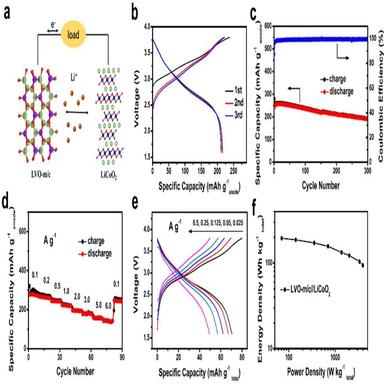
(a) Schematic illustration of the full cell. (b) Charge/discharge curves and (c) Cycling performance of LVO-m/c//LiCoO2 at 0.5 A g−1 . (d) Rate performance of LVO-m/c//LiCoO2 full cell. The specific capacity is based on the mass of anode. (e) Charge/discharge curves of LVO-m/c//LiCoO2 full cell at different current densities. (f) Ragone plots of LVO-m/c//LiCoO2. The specific capacity is calculated on the mass of total electrodes, including the anode of LVO-m/c and the cathode of LiCoO2.